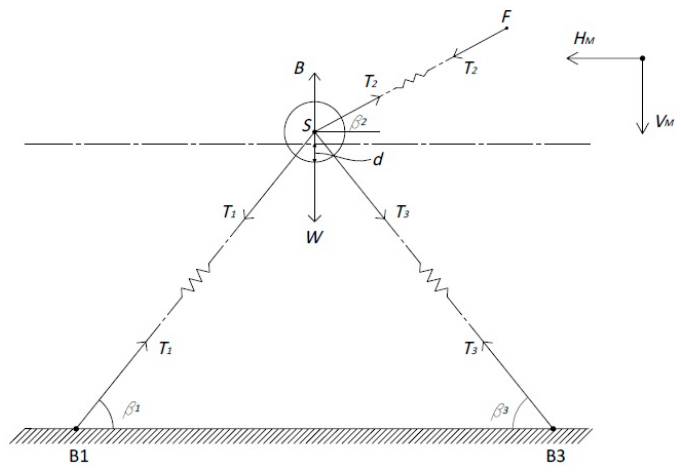
Figure 7. Notation for configuration C.